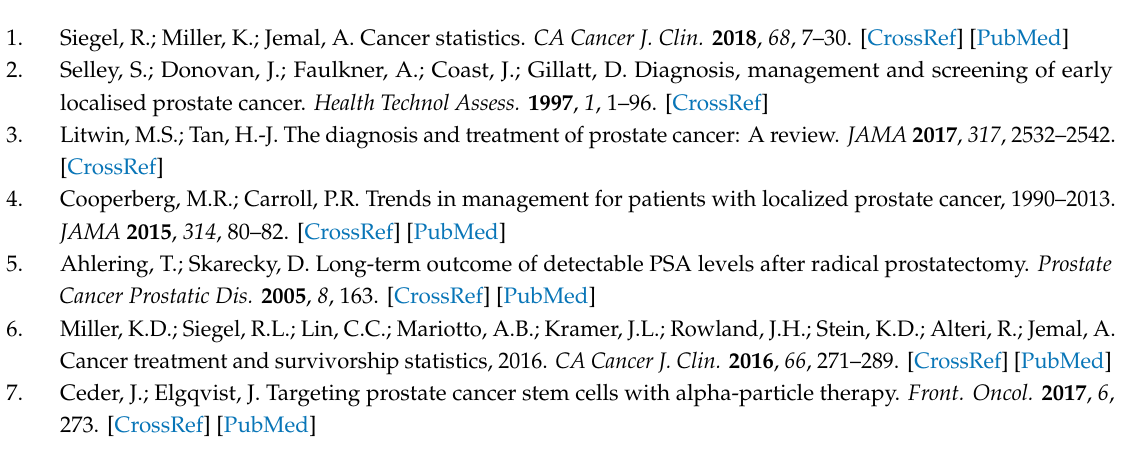
Figure S1: The e ff ect of RP-010 on colony formation rate of prostate cancer cells, Figure S2: The e ff ect of RP-010 on cell confluence and viability overtime in DU145 cells, Figure S3: RP-010-induced alterations in the cell cycle in PC-3 cells, Figure S4: The e ff ect of RP-010 on oxidative stress in DU145 and PC-3 cells, Figure S5: The e ff ect of RP-010 on nuclear events in PC-3 cells, Figure S6: RP-010 significantly reduces cell migration in PC-3 cells, Figure S7: RP-010 induces significant changes in Wnt / β -catenin signaling, Figure S8: The e ff ect of RP-010 (1 or 2 µ M) or vehicle on the expression of E-cadherin, N-cadherin, α -tubulin, and HSP90, Figure S9: The e ff ect on the heart rate of zebra fish exposed for upto 48 h with (0.3, 1, 3, 6 or 10 µ M) or without